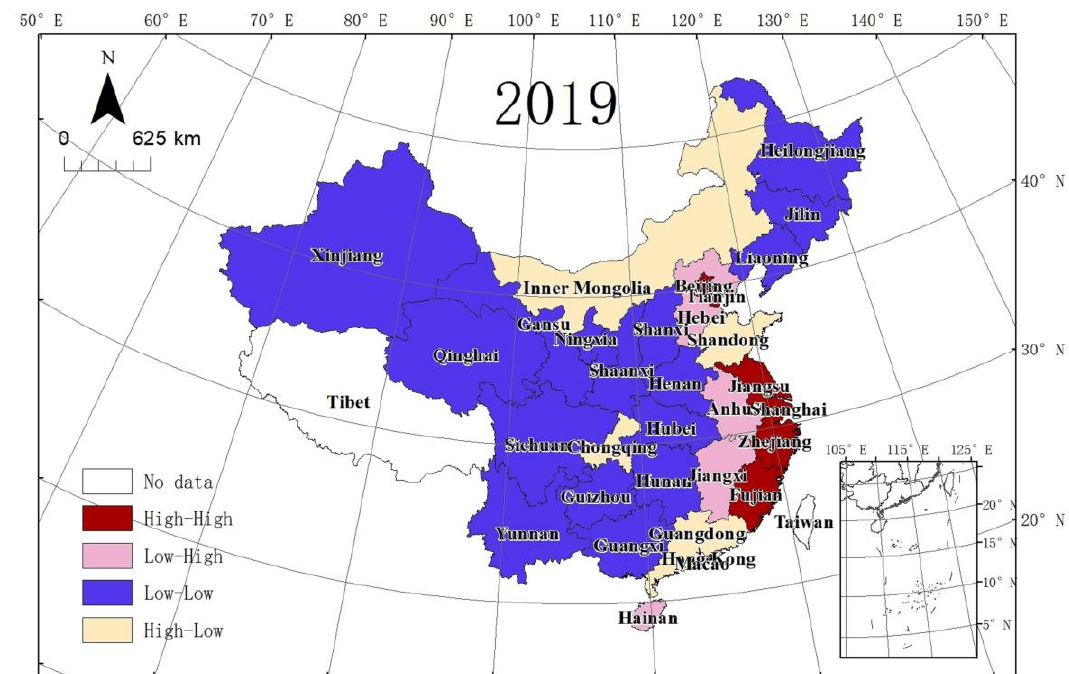
Figure 6. LISA of WRGUE in 30 provincial administrative units in 2019.